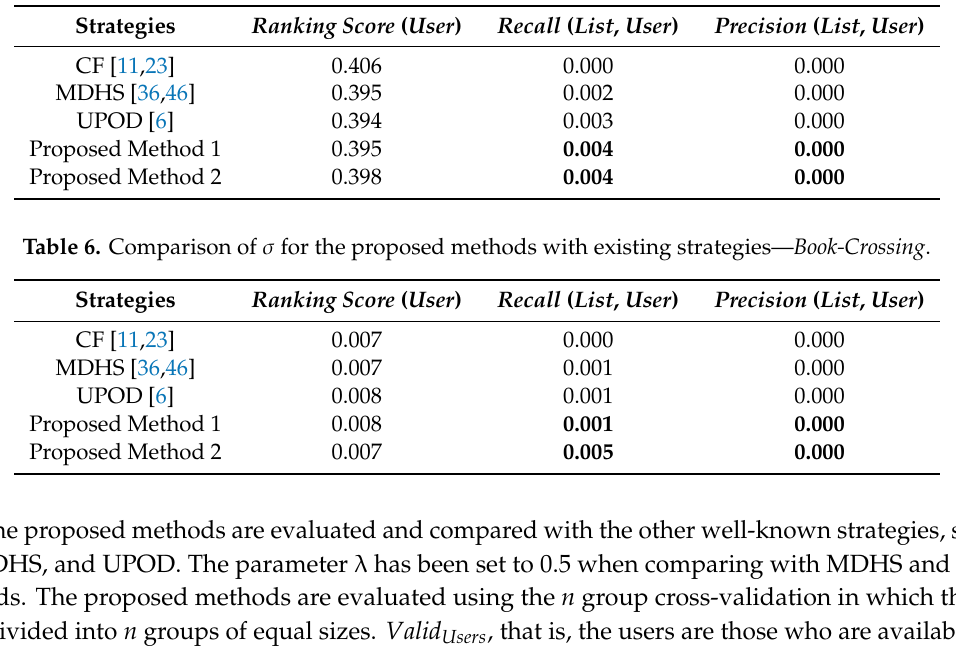
Table 5. Comparison of µ for the proposed methods with existing strategies— Book-Crossing .